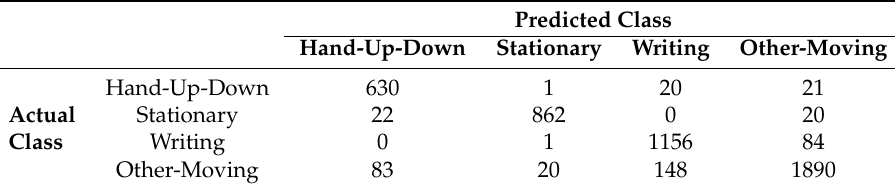
Table 3. Confusion matrix for action recognition.